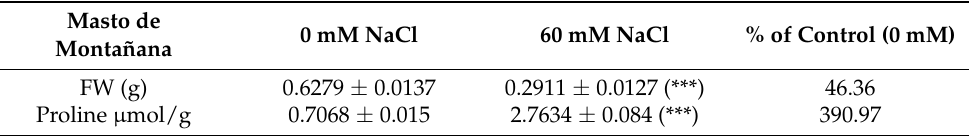
Table 1. Fresh weight and proline concentration of roots ( ± s.e. of the mean of three replicates of 11 root apexes each) after 3 weeks of culture at 0 and 60 mM NaCl. (***) Indicates significant differences ( p <